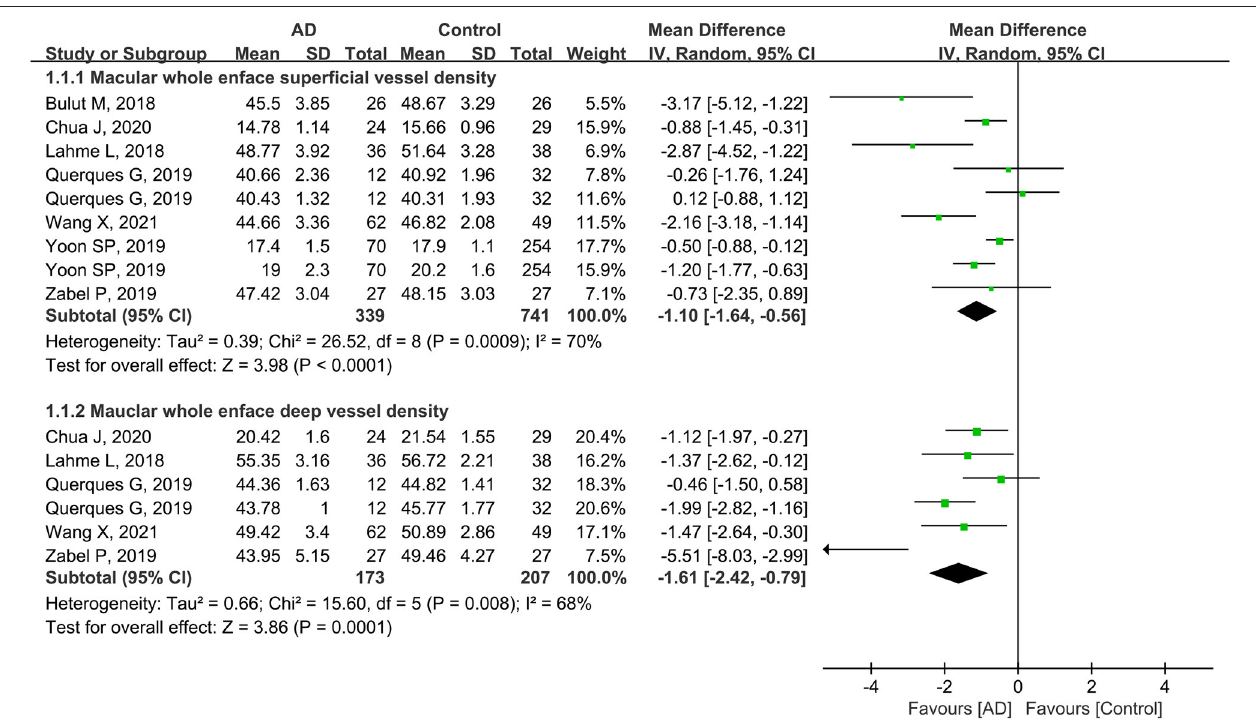
FIGURE 2 | Forest plot of macular whole enface superficial and deep vessel density between AD and control groups.